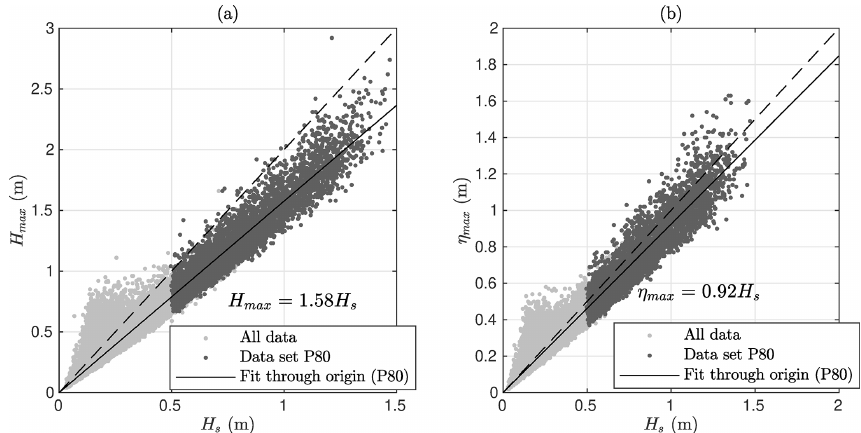
Figure 8. The wave height of the single highest wave ( H max , a ) and the maximum crest height ( η max , b ) relative to the significant wave height, H s , at Suomenlinna